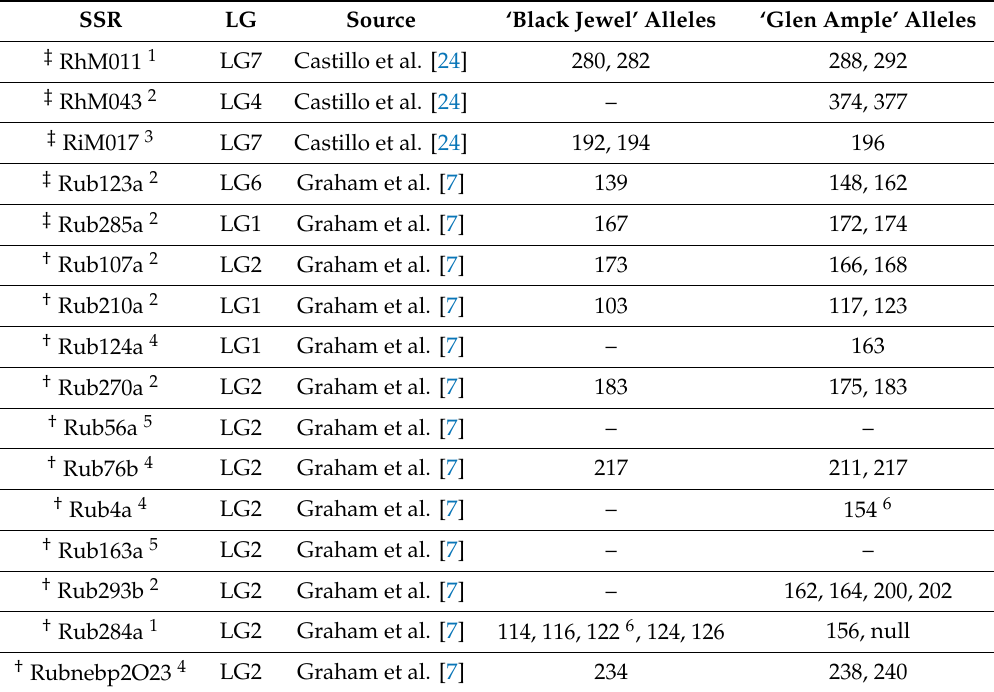
Table 1. SSR markers applied to the population and their allele sizes in base pairs